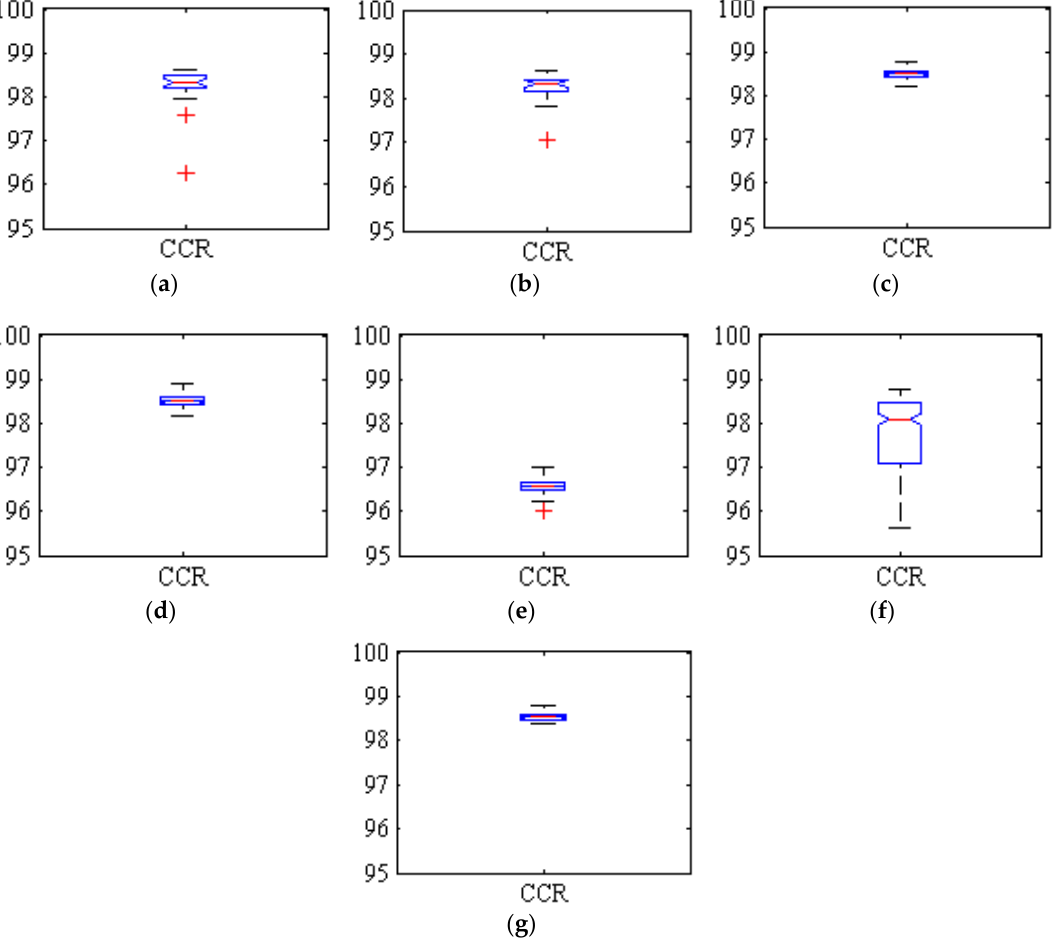
Figure 3. Boxplots of the correct classification rate (CCR) obtained by the classifiers for the 275 executions. ( a ) Hybrid ANN-ICA; ( b ) Hybrid ANN-HS; ( c ) SVM; ( d ) kNN; ( e ) LDA; ( f ) Voting method executions. ( a ) Hybrid ANN-ICA; ( b ) Hybrid ANN-HS; ( c ) SVM; ( d ) kNN; (e) LDA; ( f ) Voting method with LDA; ( g ) Voting method without with LDA; ( g ) Voting method without LDA.